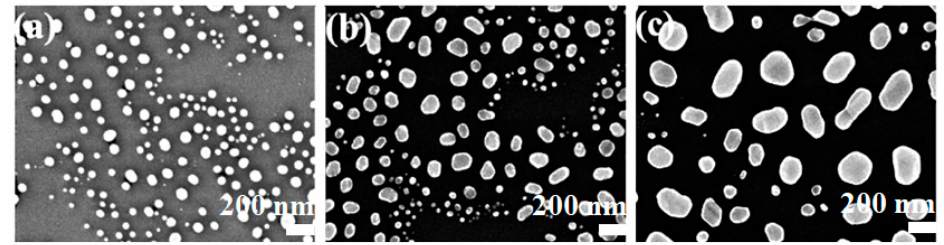
Figure 4. SEM images of Au films deposited on silicone oil surfaces with film thicknesses of ( a ) 5 nm, ( b ) 10 nm, and ( c ) 20 nm annealed at 600 °C for 1 h.